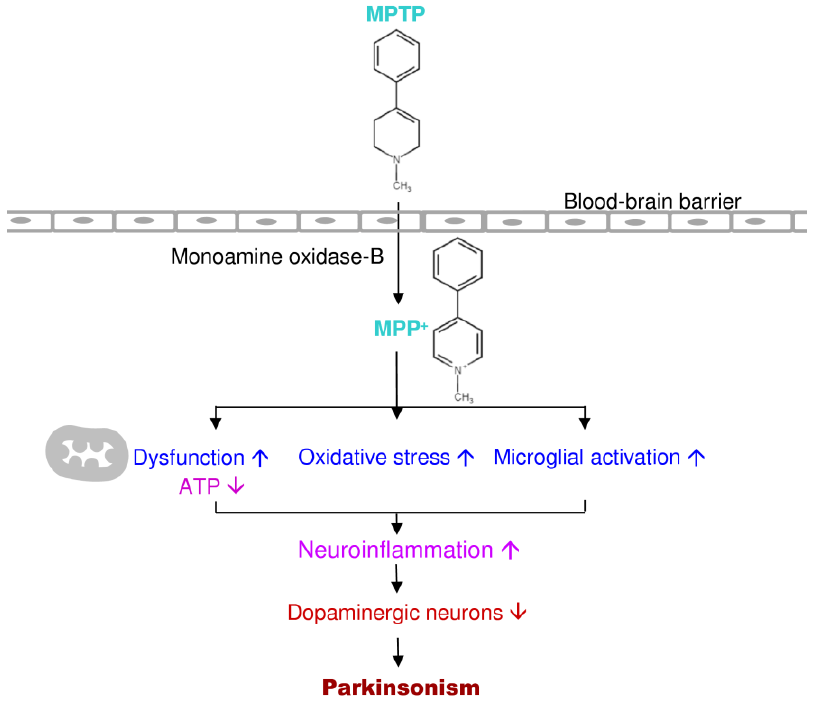
Figure 5. Putative mechanism of action of 1-Methyl-4-phenyl-1,2,3,6-tetrahydropyridine (MPTP) (and MPP + ) in PD progression.